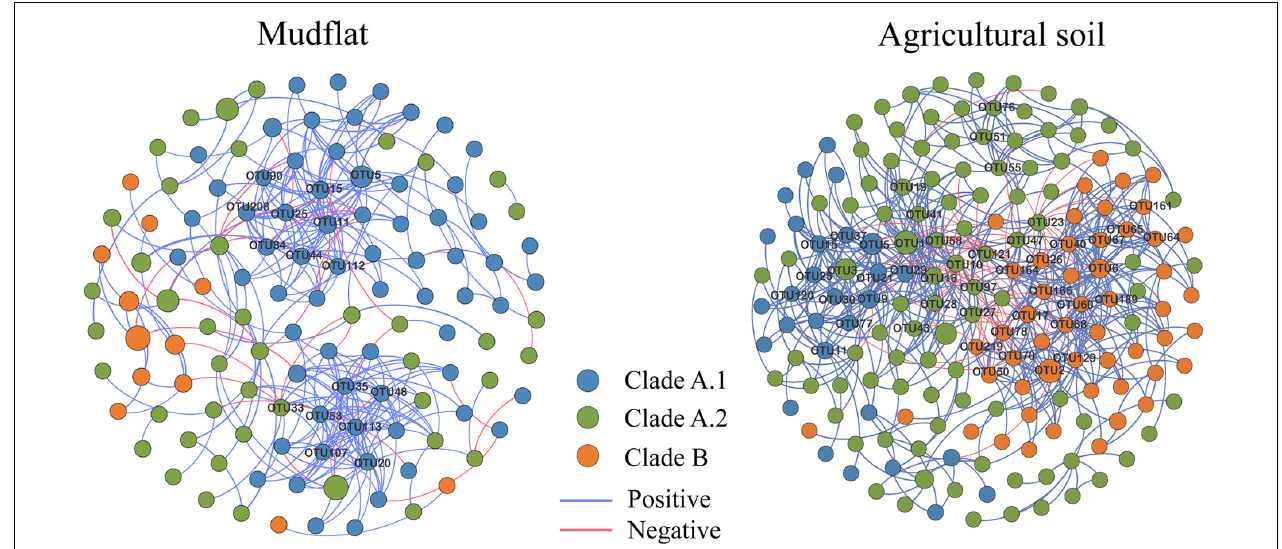
FIGURE 6 | Co-occurrence network of comammox Nitrospira species. The nodes represent OTUs, the relationship of two OTUs in the network was shown by an edge (Coefficient r ≥ 0.6, significant P ≤ 0.01). Nodes in different colors represent different clades of comammox Nitrospira , and the size of the nodes was proportional to their relative abundance; the pink and blue edges represent the positive and negative correlations, respectively, and the thickness of each connection between two nodes is proportional to the value of correlation coefficient. Hub nodes of co-occurrence were labeled in